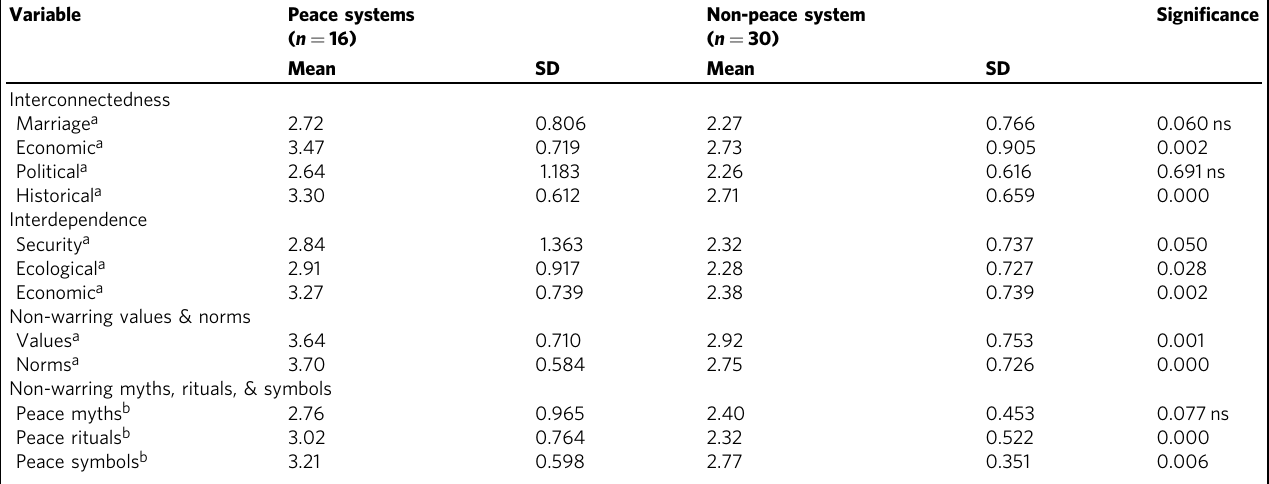
Table 3 Peace systems and non-peace systems compared regarding the subcomponents of interconnectedness, interdependence, non-warring values and norms, and peace myths, peace rituals, and peace symbols. Variable